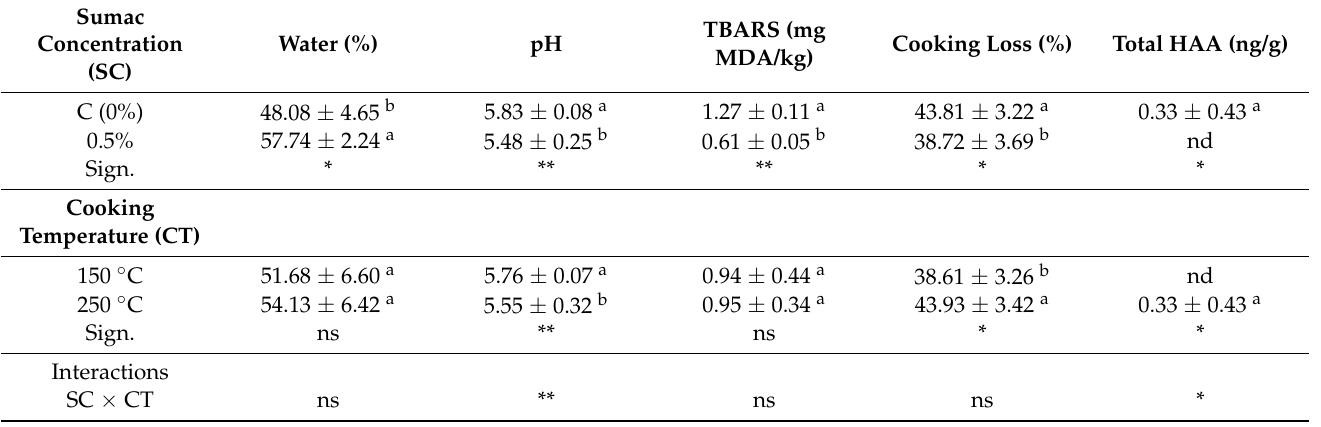
Table 2. Various analysis results of cooked meatballs (mean ±